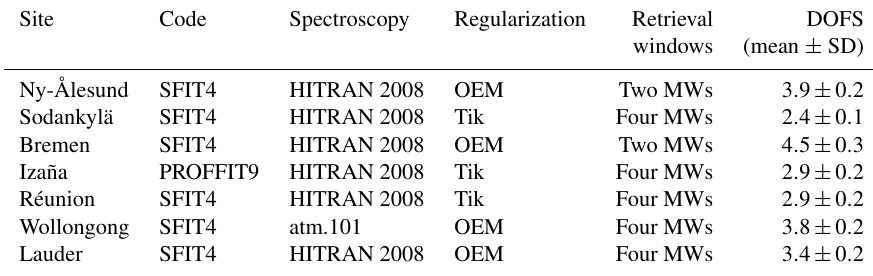
Table 3. NDACC retrieval settings at seven FTIR sites. For sites using two microwindows, retrieval windows are 2441.8–2444.6 and 2481.1– 2482.5cm − 1 . For sites using four microwindows, retrieval windows are 2481.3–2482.6, 2526.4–2528.2, 2537.85–2538.8 and 2540.1– 2540.7cm − 1 .